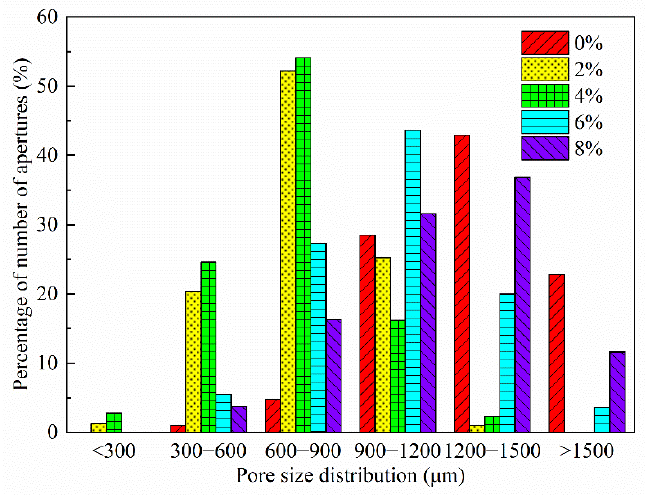
Figure 18. Effect of silica fume dosing on pore size distribution.